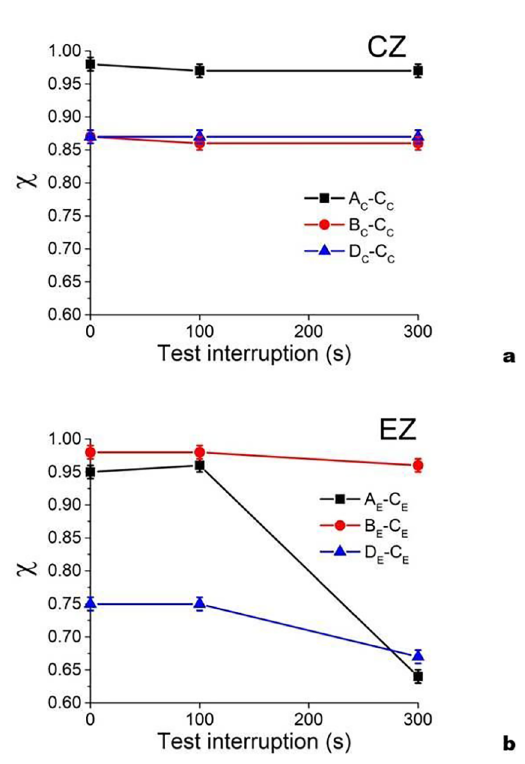
Figure 10. Highest permeability factors χ obtained for both